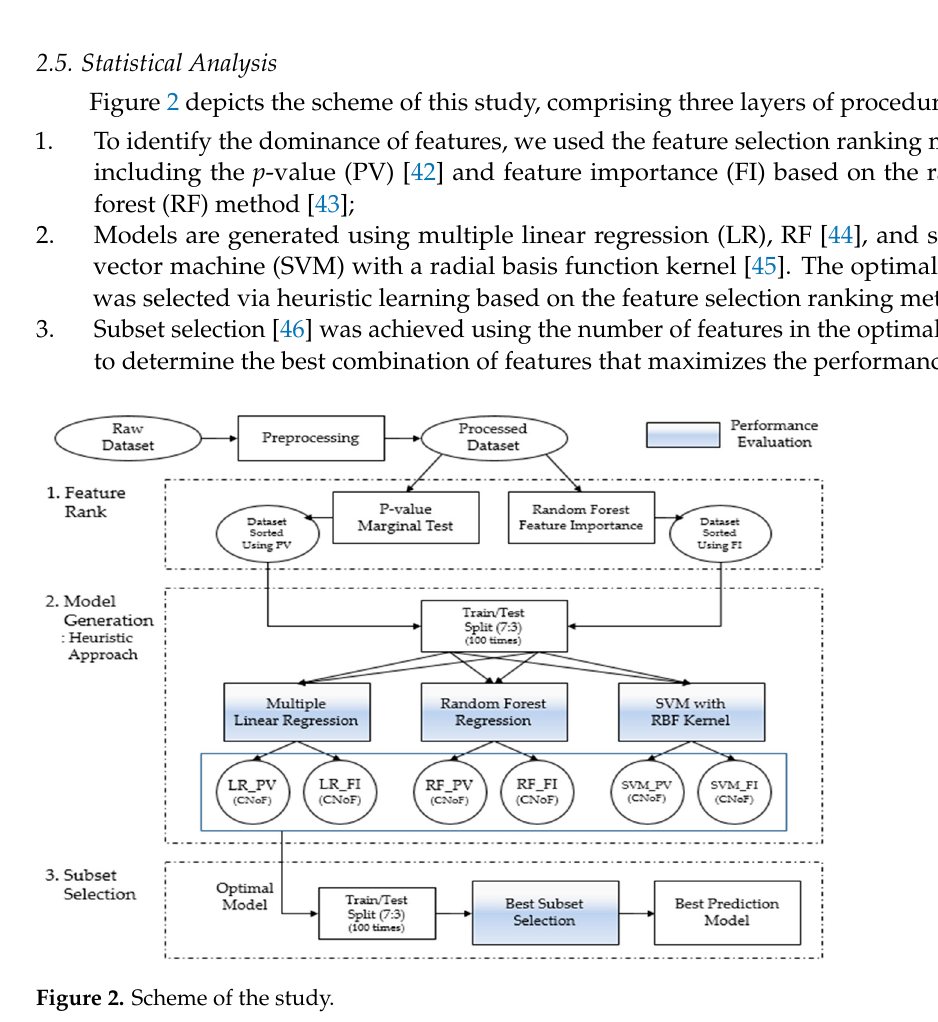
Figure 2. Scheme of the study.